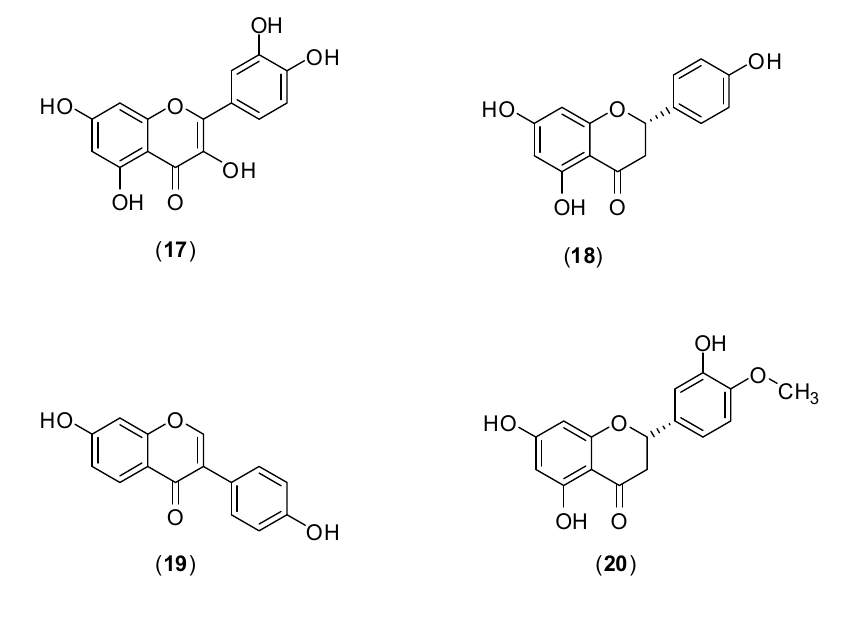
Figure 11. Structures of compounds 17 – 20